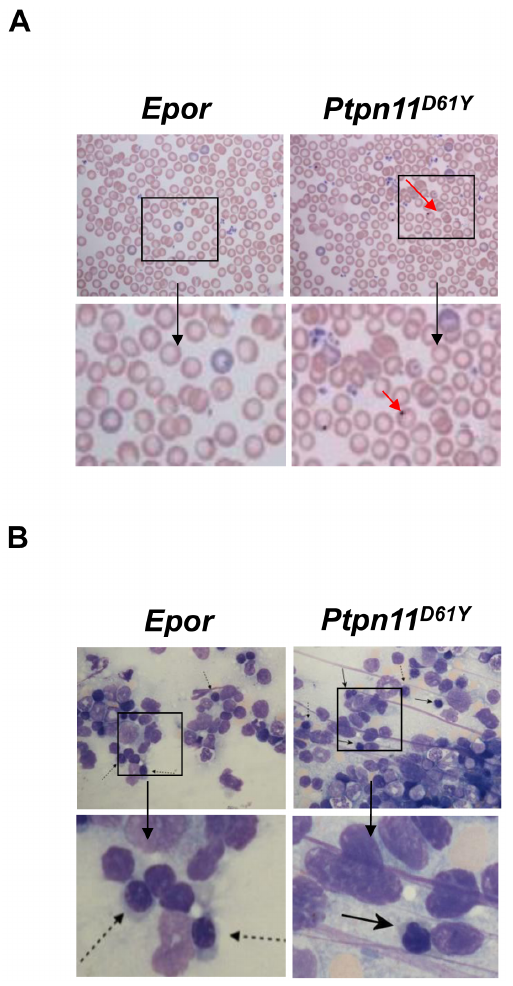
Figure 1. Ptpn11 D61Y mice have defective erythropoiesis. (A) Howell-Jolly bodies in peripheral blood (X100) of Ptpn11 D61Y mice. (B) Hematoxylin and eosin-stained BM cells (X100) from Ptpn11 D61Y mice contain abnormal erythroblasts (solid arrow). Normal erythroid progen- itors from control Epor mice are indicated (dashed arrow).